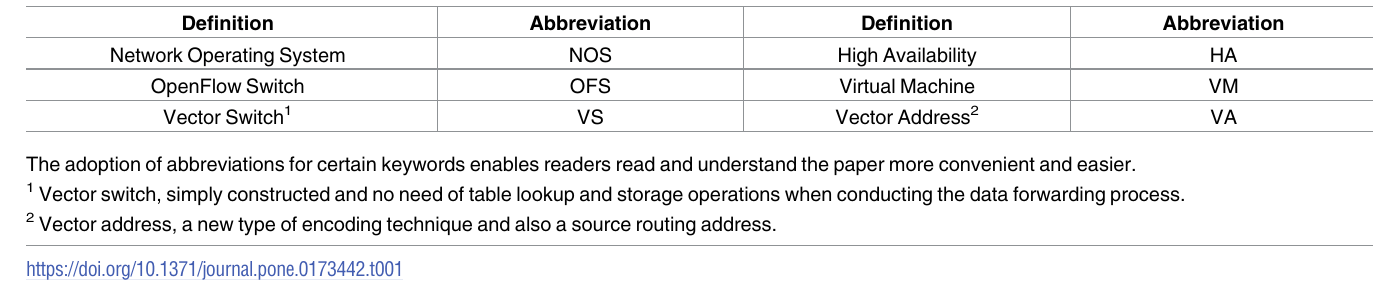
Table 1. Abbreviations used in Figs